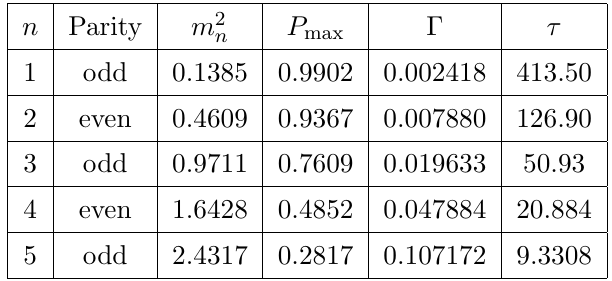
Table 1. The mass spectrum m 2 , relative probability P max , FWHM (cid:0) and life-time (cid:28) of the n resonances for the single brane model (3.1).